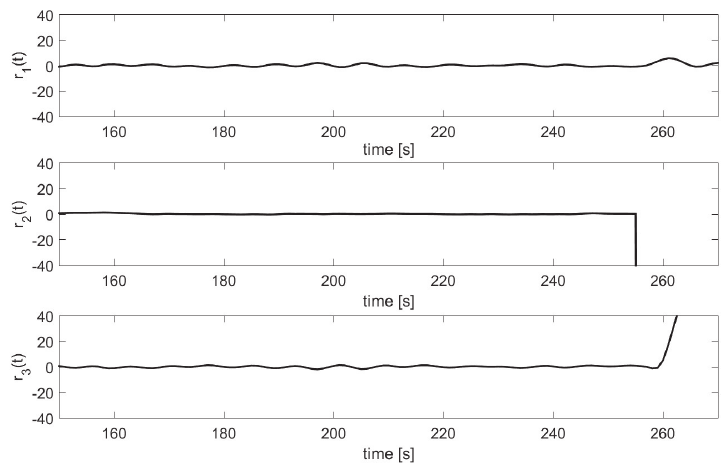
Figure 9. Response of residual to the sensor fault f s 2